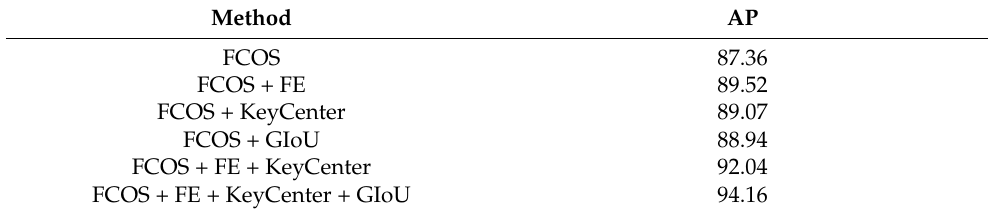
Table 2. Ablation experiments.